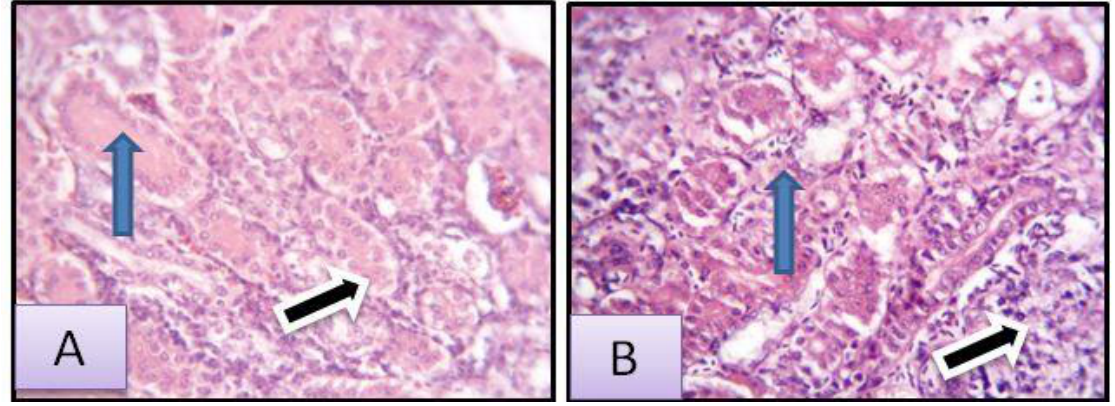
Fig.7: kidney section (A) black arrow showed coagulative necrosis of tubule &blue arrow showed presences of hyaline cast X 40, while B : the blue arrow showed the cell swelling &black arrow showed infiltration of inflammatory cell X 40.